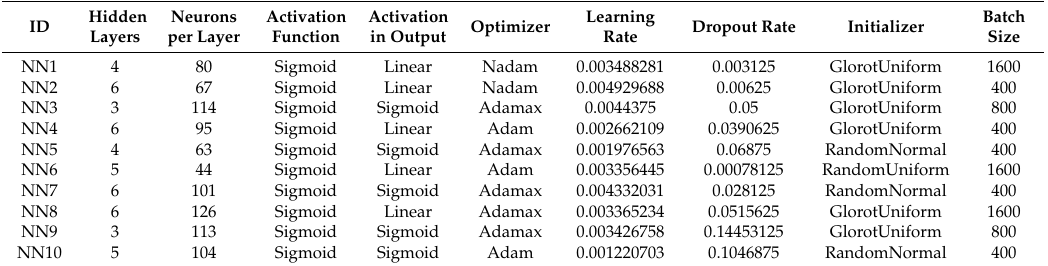
Table 1. Hyperparameter combinations producing the 10 best performing neural